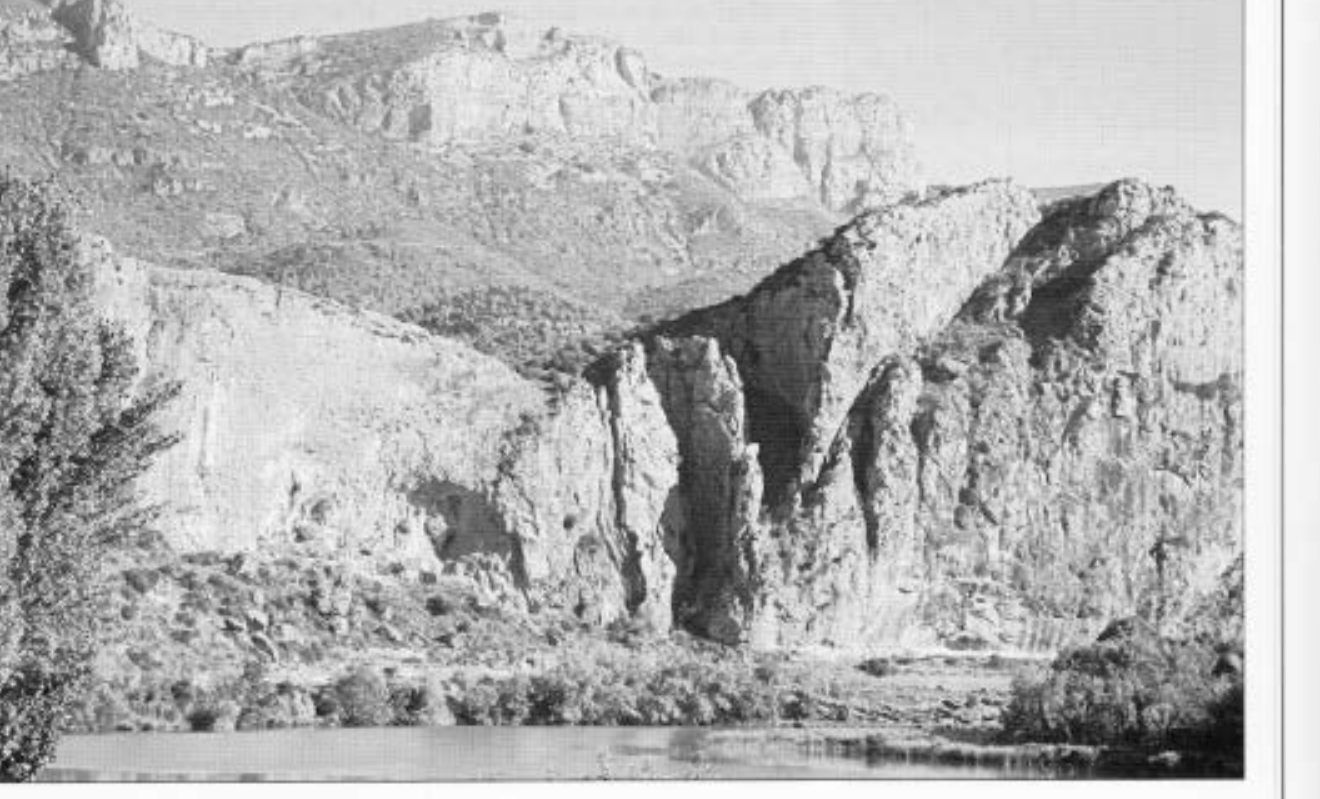
Figure 5 Topographical setting of the Roca dels Bous Middle Palaeolithic site.